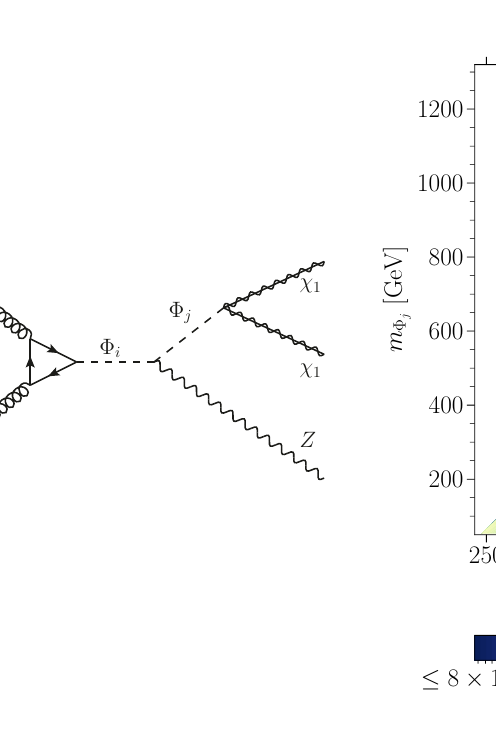
Figure 4 . Left: illustration of [( gg (cid:8) i Z + ((cid:8) j (cid:31) 1 (cid:31) 1 )] yielding a mono- Z signal at the ! ! ! LHC: (cid:8) i = H and (cid:8) j = a , or (cid:8) i = A and (cid:8) j = h . Decays of the type A Zh 125 are suppressed ! by alignment, see the discussion in section 2.3. Right: estimated reach in the scalar topology for a luminosity of L = 3000 fb (cid:0) 1 , assuming a systematic uncertainty of the background of (cid:1) = 5 %, shown in the plane of the masses of the involved scalars. The color coding shows the best reach for the ( Z + E miss ) (cid:12)nal state, i.e. excluding the Z ‘ + ‘ (cid:0) branching ratio. See appendix D and text T ! for